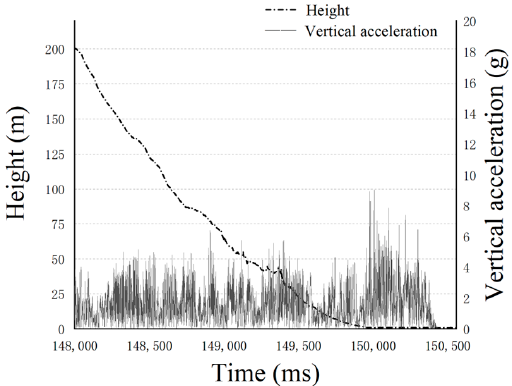
Figure 8. The vertical acceleration of a hard landing.